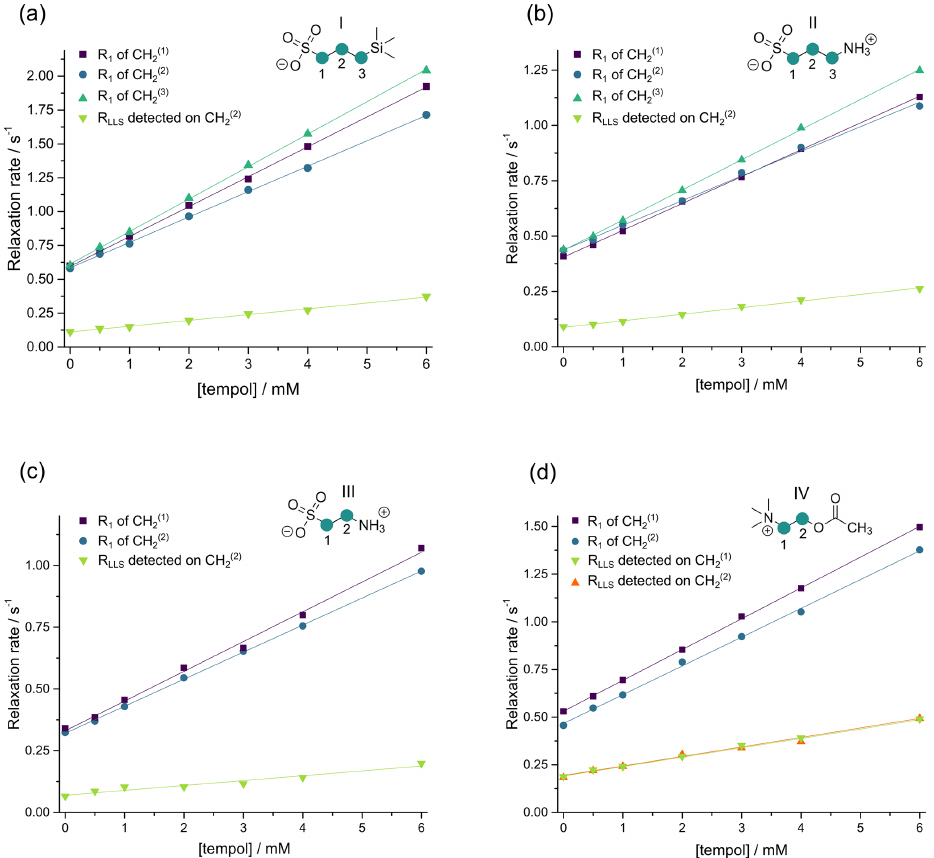
Figure 4. Relaxation rate constants R 1 = 1 /T 1 and R LLS = 1 /T LLS in CH 2 groups of the four molecules I–IV as a function of the TEMPOL concentration. In (a) and (b) , the LLSs were excited by triple SLIC, in (c) and (d) by double SLIC, both with an RF amplitude of 13.5Hz to match the condition for double-quantum level anti-crossing (DQ LAC). In all cases, the LLSs were reconverted into magnetization by single SLIC applied to the CH (2) group, except for compound IV, where two sets of experiments were performed with reconversion into 2 magnetization of either CH (1) or CH (2) groups. The relaxivities r 1 and r LLS correspond to the slopes of the linear 2 2